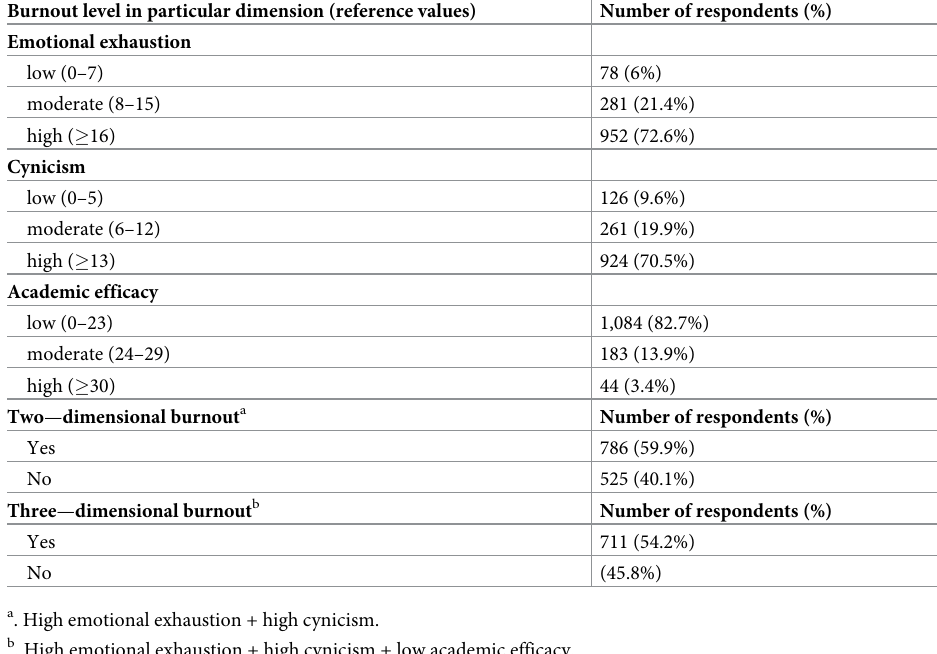
Table 4. Prevalence of high, moderate and low levels of burnout in particular dimensions and of the overall burn- out according to the two- and three-dimensional criteria (N = 1,311). Burnout level in particular dimension (reference